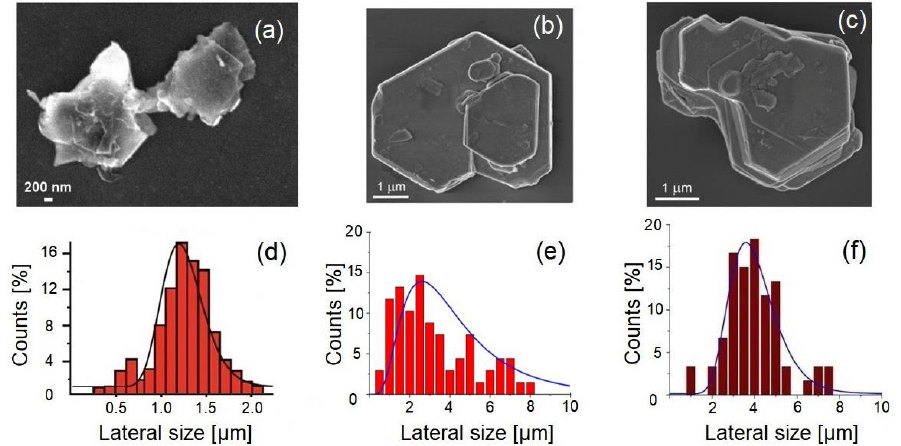
Figure 2. Comparison of the representative high-resolution SEM images and statistical analysis determined from the images. Exfoliated nanolayers with the LPE of WS 2 , assisted by ( a ) Iris, ( b ) Polarclean (taken from [70] with permission), ( c ) NMP. Lateral scale size distribution analysis of WS 2 with ( d ) Iris, ( e ) Polarclean (taken from [70] with permission), ( f ) NMP.